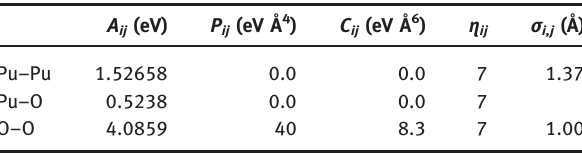
Table 1: The potential parameters used in the present work. Z Pu = 1.96e and Z O = –